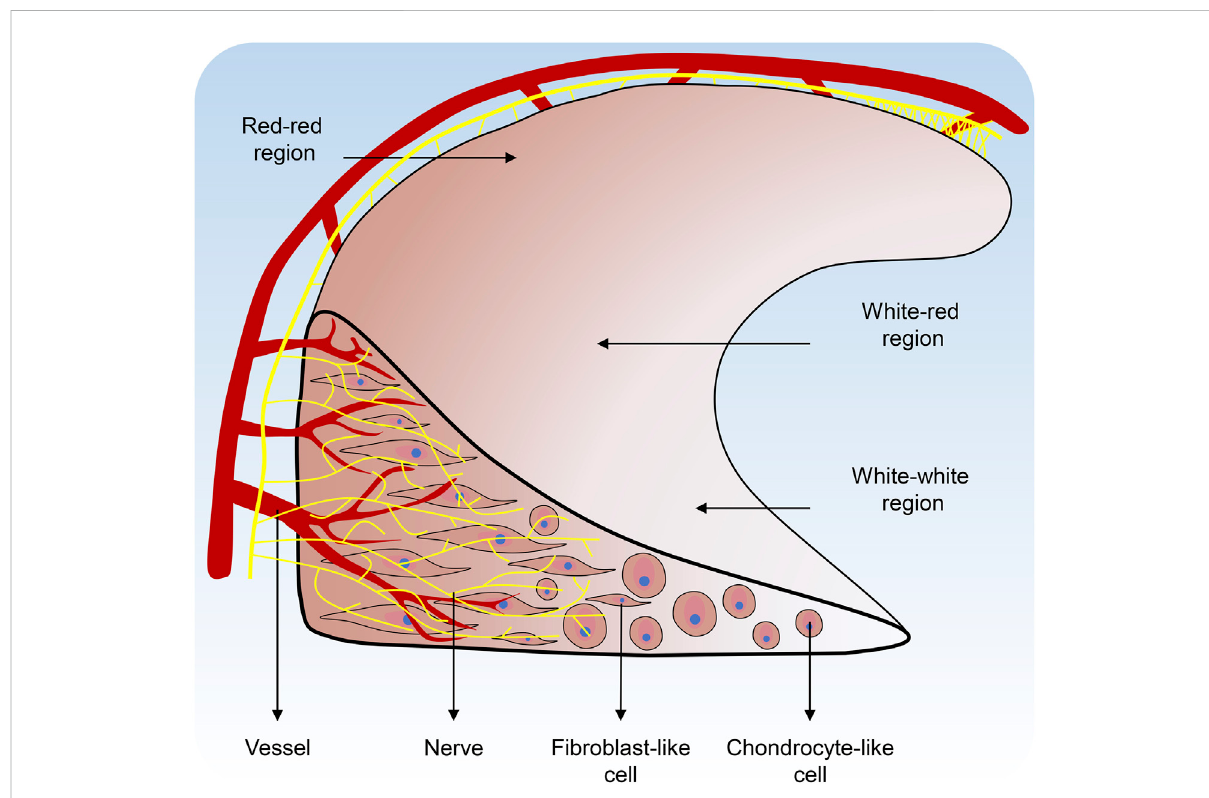
FIGURE 2 Regional variations in vascularization, nerve distribution, and cell populations of the